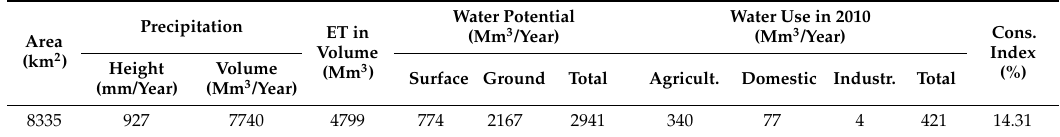
Table 1. Available water resources and water uses in Crete (adapted from Angelakis [16]).